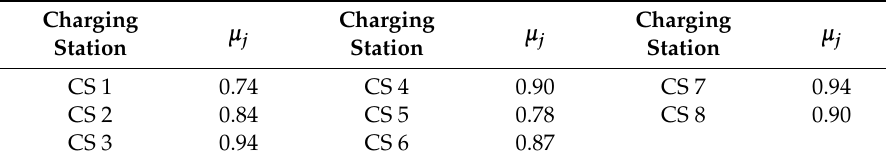
Table A1. Value of parameter µ j for each charging station node.